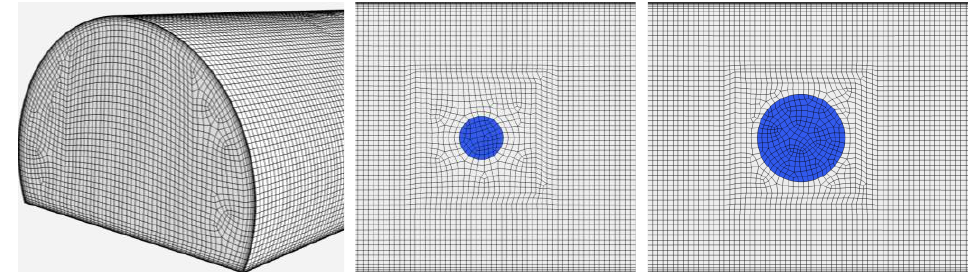
Figure 2. Mesh used for the simulations, with a 3D view of the wind inlet on the left, and a zoomed in view from the bottom of the 0.85 m (center) and 1.7 m (right) diameter pool.